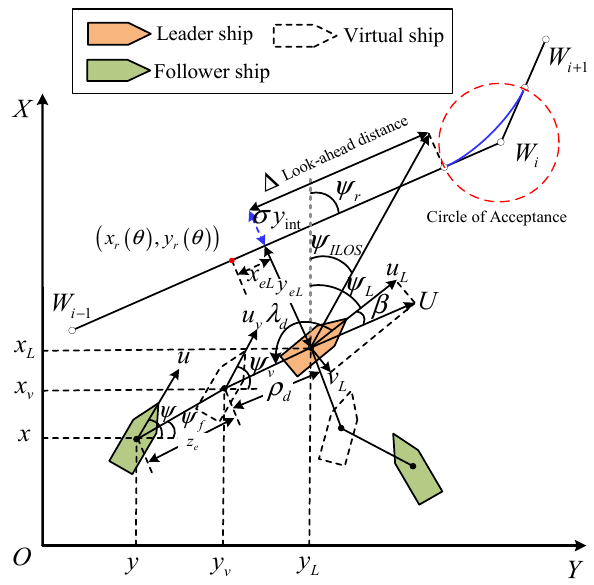
Figure 2. The leader–follower framework with the DLLOS guidance principle.